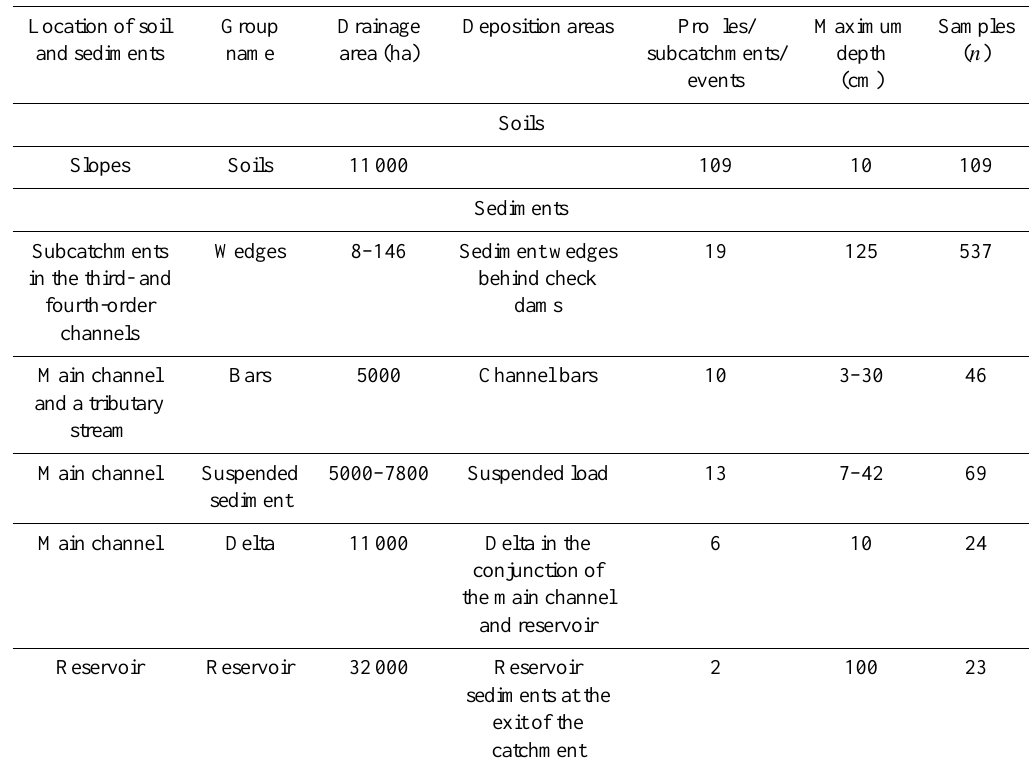
Table 1. Main location and characteristics of the sampling areas within the catchment. Location of